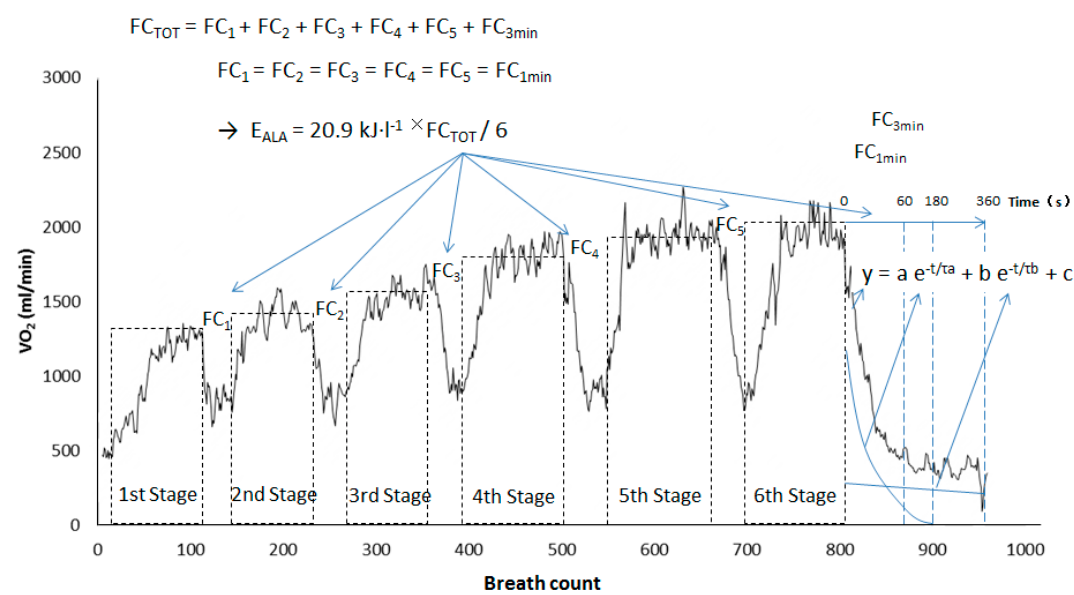
Figure 1. Illustration of the calculation of E ALA in the incremental table tennis stroke test with the raw data (breath by breath) of one subject. Note: FC TOT is the fast component of VO 2 -off kinetics of the whole test (first to sixth stage). FC n is the fast component of VO 2 -off kinetics of the first five stages (FC 1 , FC 2 , FC 3 , FC 4 , FC 5 ). FC 3min is the fast component of VO 2 -off kinetics in the first 3 min of the recovery. FC 1min is the fast component of VO 2 -off kinetics in the first 1 min of the recovery. E ALA is the anaerobic alactic energy contribution of each stage. In y = a e − t/ τ a + b e − t/ τ b + c, y—VO 2 in the recovery after the sixth stage, a and b are the amplitudes of the fast and slow components, respectively, τ a and τ b are the corresponding time constants, and c is the VO 2 at rest while t is time of recovery in seconds.